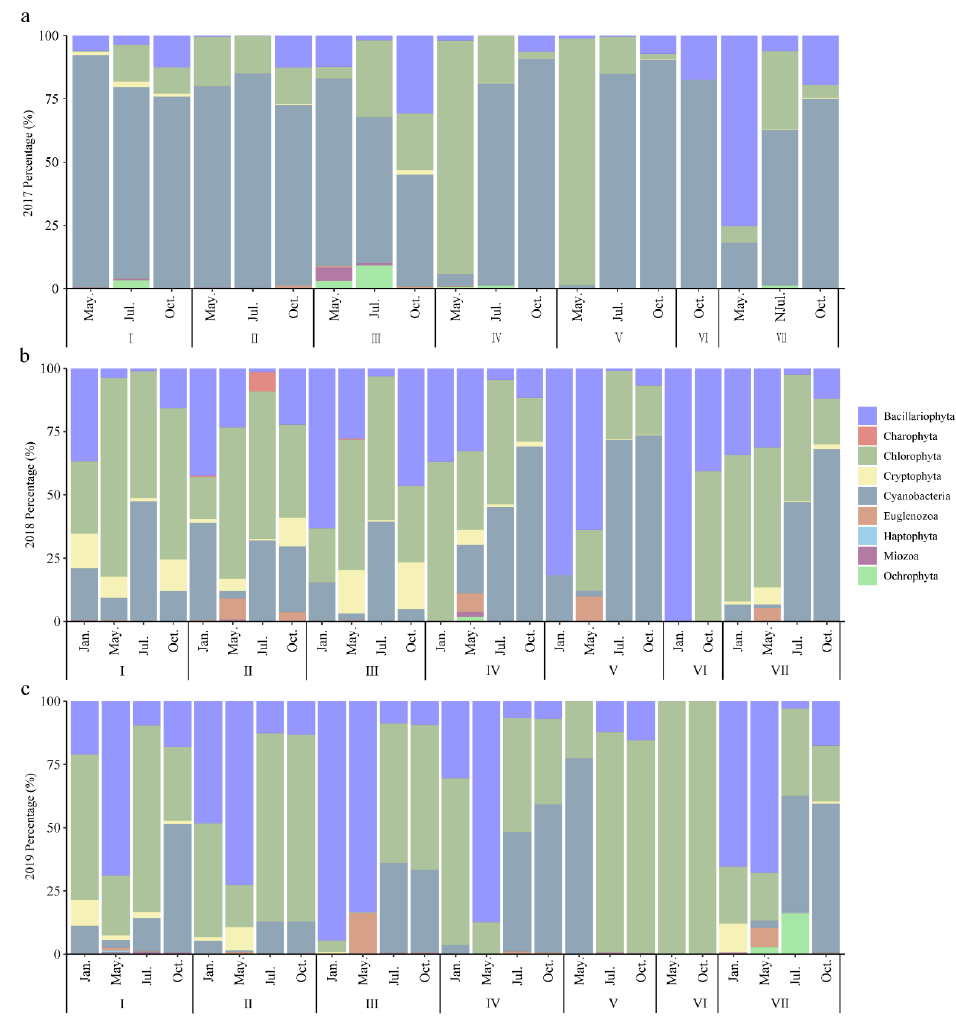
Figure 5. Relative abundance of vertical phytoplankton in the Danjiangkou Reservoir (( a ) 2017 percentage; ( b ) 2018 percentage; ( c ) 2019 percentage; the Roman numerals were the layers in the water column).